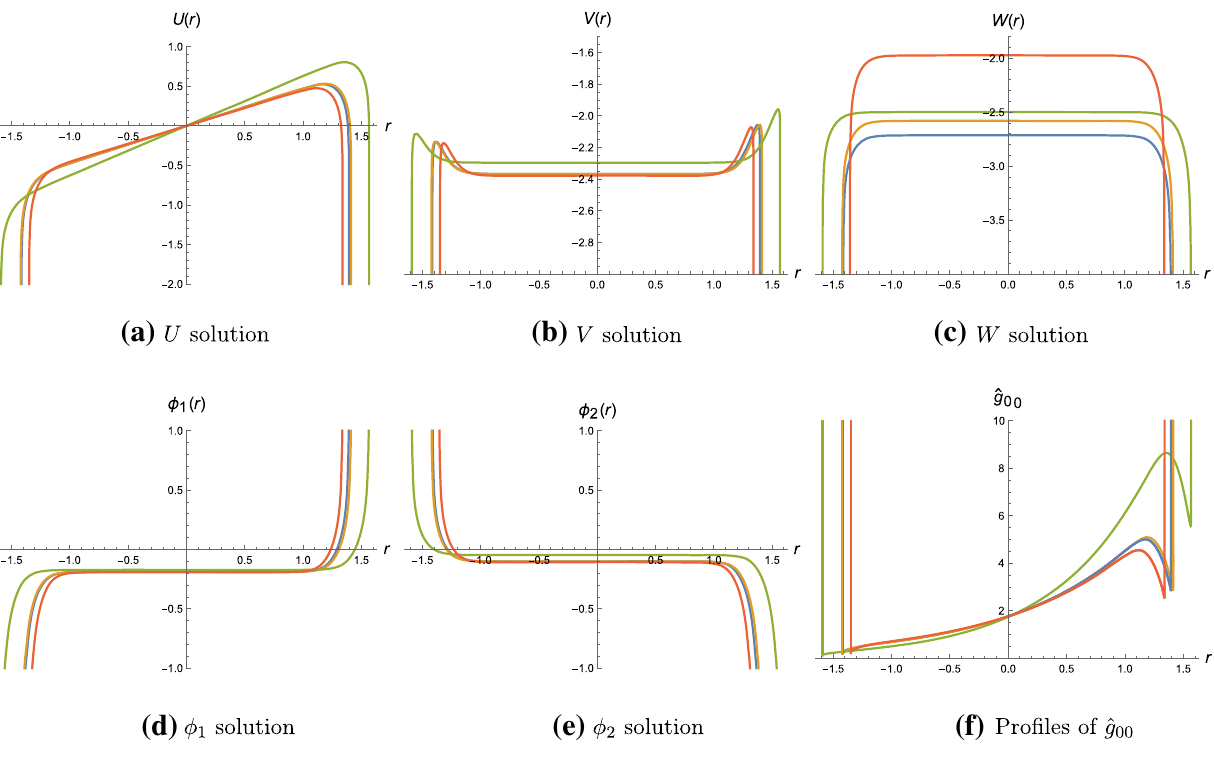
Fig. 19 RG flows between AdS 3 × S 2 × R 2 fixed points and curved domain walls for SO ( 2 ) × SO ( 2 ) twist in SO ( 3 , 2 ) gauge group. The blue, orange, green and red curves refer to ( z 1 , z 2 ) = ( 1